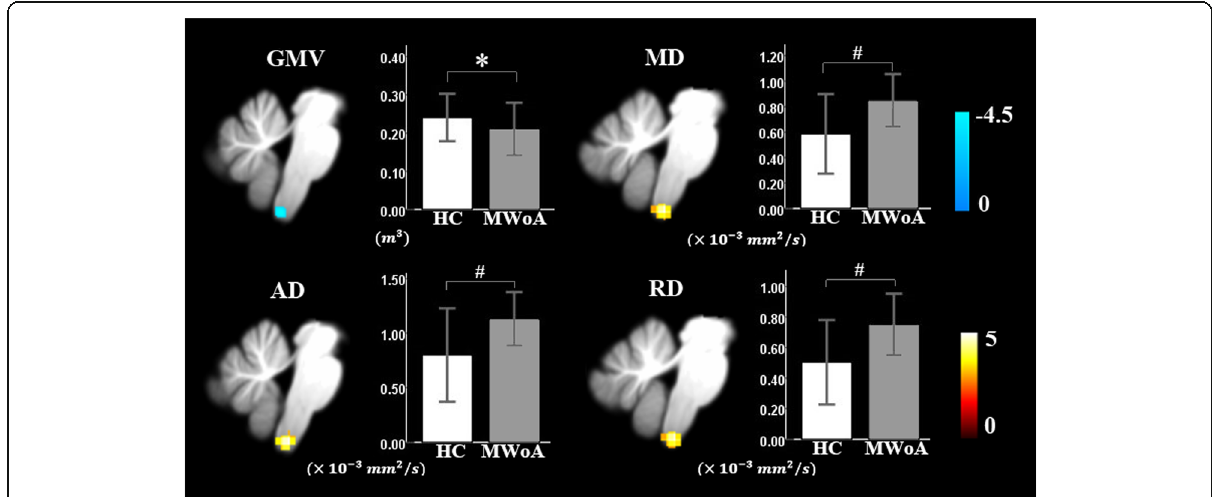
Fig. 3 Sagittal view of the spinal trigeminal nucleus (SpV) with significant differences in gray matter volume and diffusion characteristics between MWoAs and healthy controls. * Statistical significance of p<0.001 at the voxel level, FWE-corrected p<0.067 at the cluster level; # Statistical significance of p<0.001 at the voxel level, FWE-corrected p<0.05 at the cluster